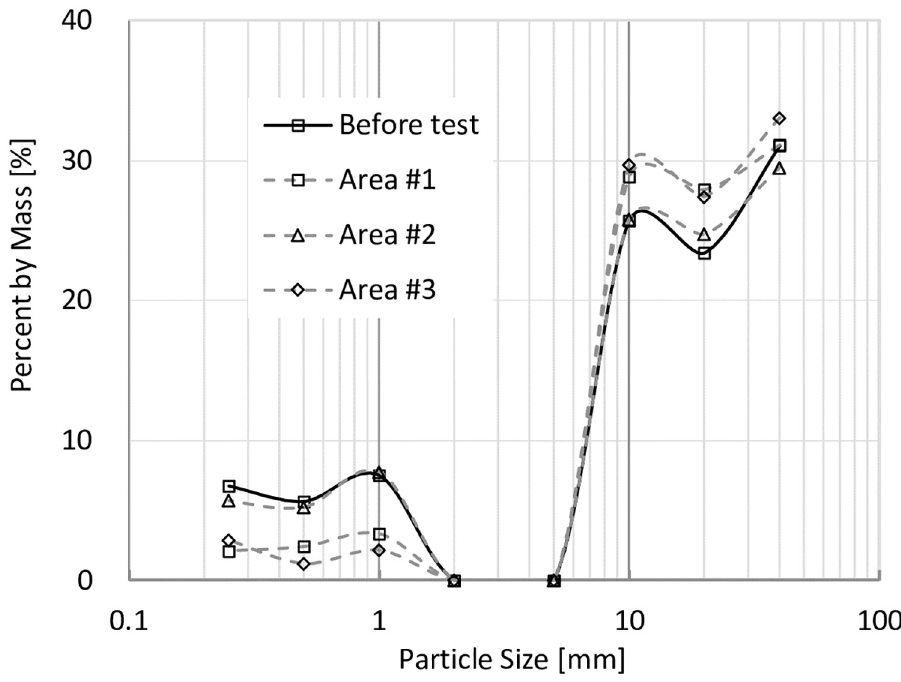
Fig 14. Frequency of particles with different sizes in each area of the model with VFR = 50%.